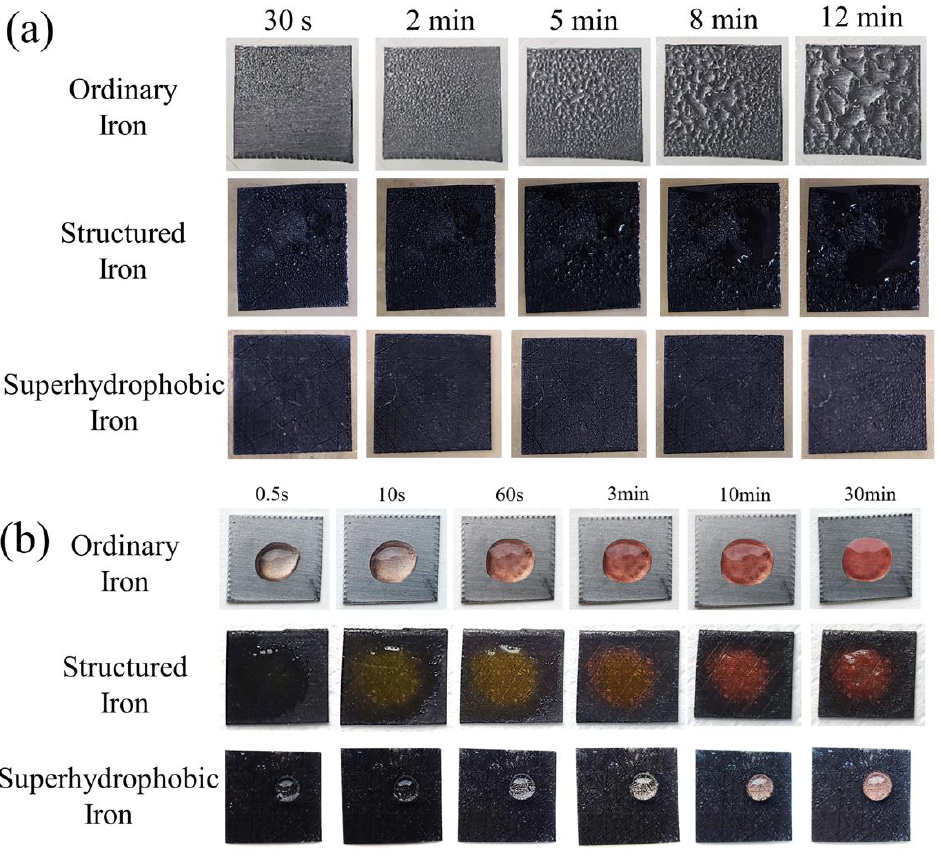
Figure 4. ( a ) Photos of three samples—ordinary iron, structured iron and SHI—for anti-condensation tests as time prolonged to 12 min. ( b ) Photos of droplets of hydrochloric acid (pH = 1) on the surface of the ordinary iron, structured iron and SHI as time prolonged to 30 min.